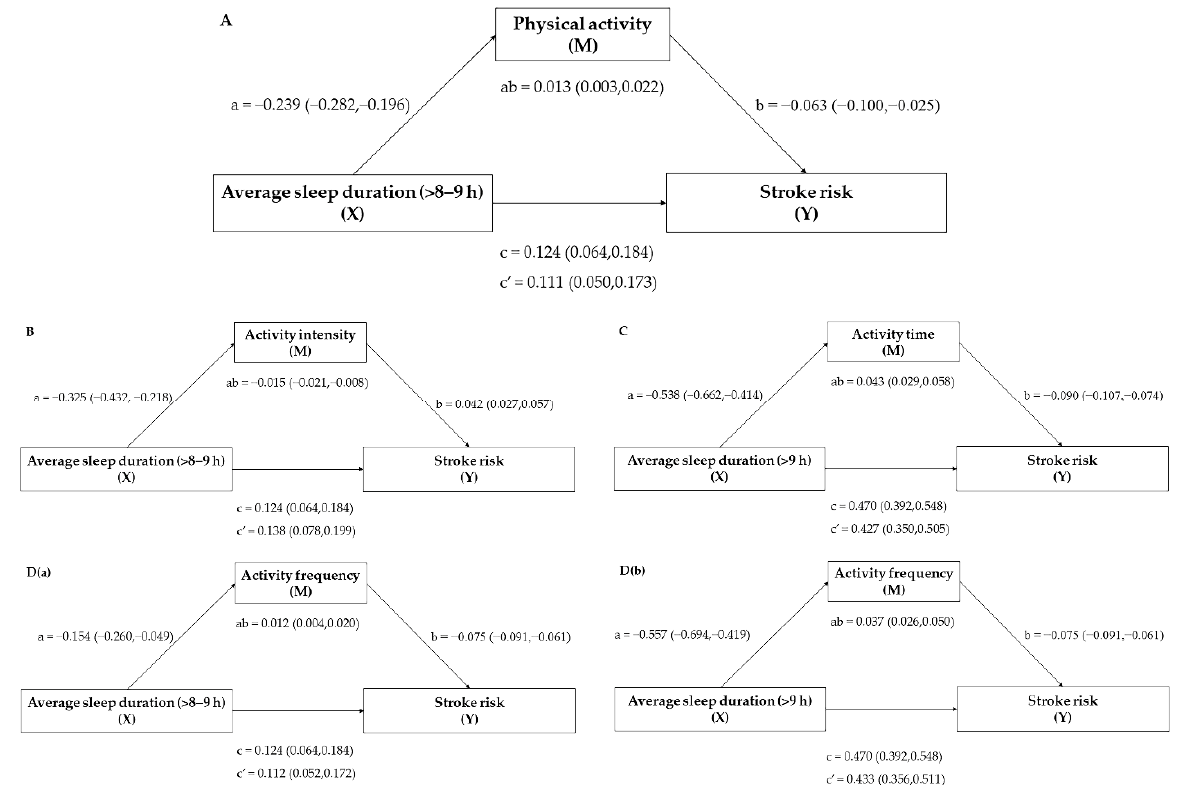
Figure 2. Mediation model ( A ) for the relationship between a sleep duration of >8~9 h and stroke risk,